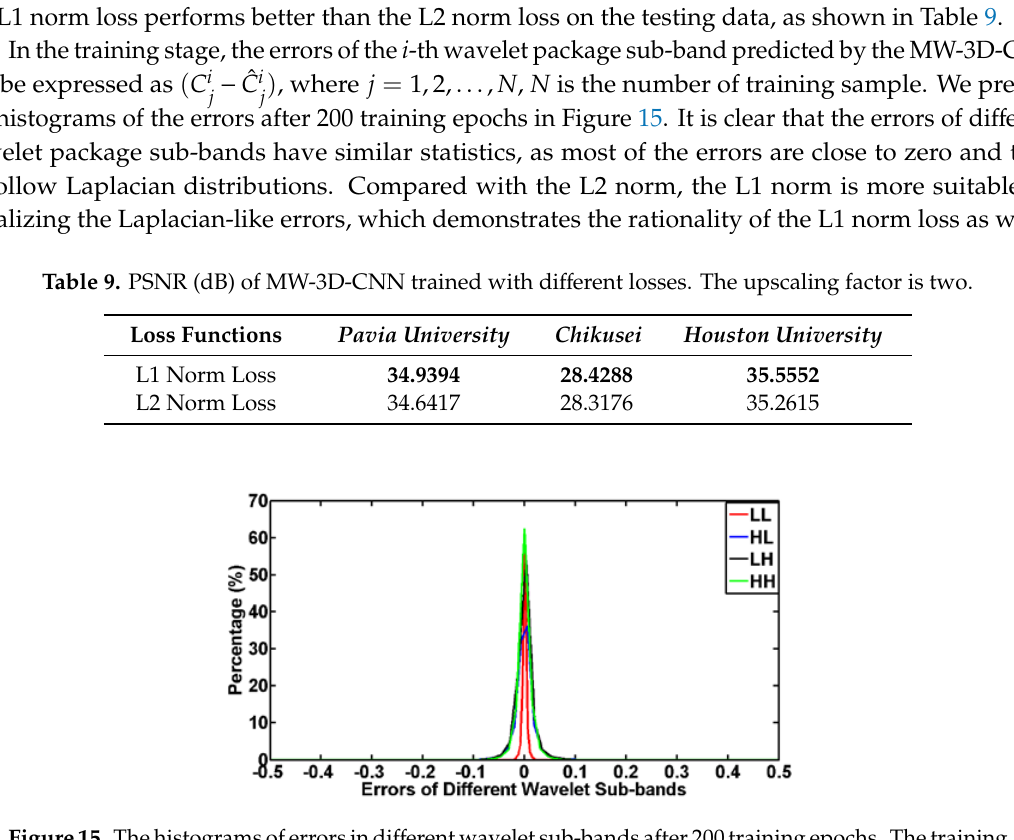
Figure 15. The histograms of errors in different wavelet sub-bands after 200 training epochs. The training data is extracted from Pavia University , the MW-3D-CNN is trained with the L1 norm loss, and the upscaling factor is two.